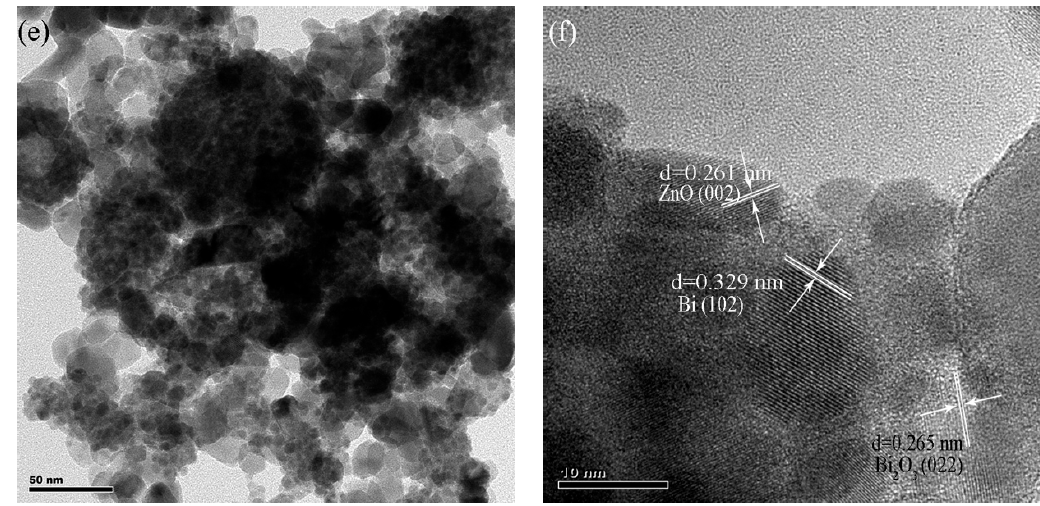
Figure 3. HRTEM (high-resolution transmission electron microscope) images of ( a , b ) Bi, ( c , d ) ZnO, and ( e , f ) Bi-ZnO-80.